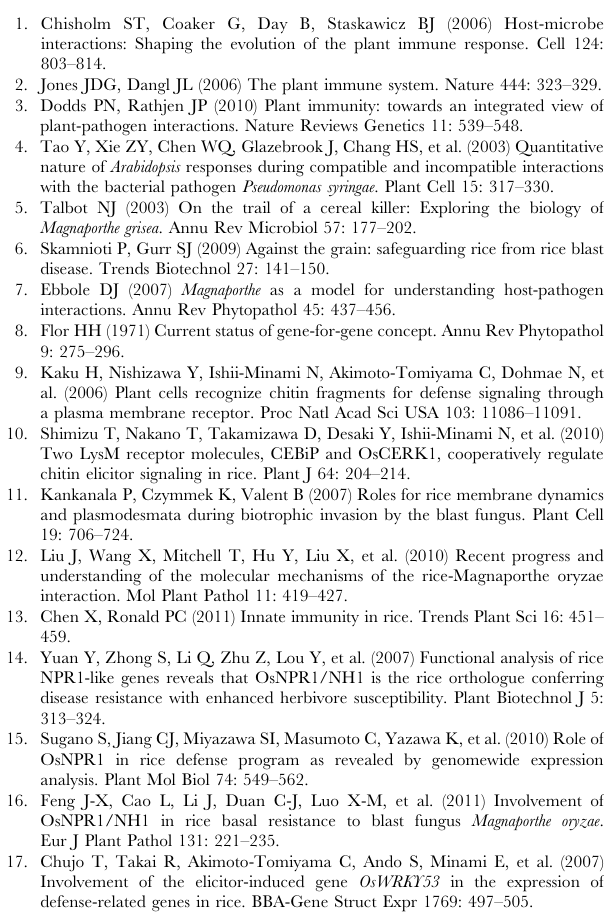
Figure S1 The 500-sliding window analysis of the genes involved in amino acid metabolism (a), cell wall metabolism (b), stress response (c), transporter (d), lipid metabolism (e) and RNA metabolism (f). The solid lines represent the percentages of certain functional category in a 500-sliding window in IRBL18 (red), IRBL22 (blue) and LTH (green). The blue dotted lines represent the 95% significance levels of greater or smaller than the reference. Table S1 List of 755 differentially regulated genes during rice early responses to Magnaporthe oryzae . Table S2 List of quantitative RT-PCR results of selected genes. Table S3 List of primers for quantitative RT-PCR. Table S4 List of differentially regulated receptor kinase genes and nucleotide binding and leucine rich repeat ( NB-LRR ) genes. Table S5 List of enzyme genes illustrated in Figure 5.